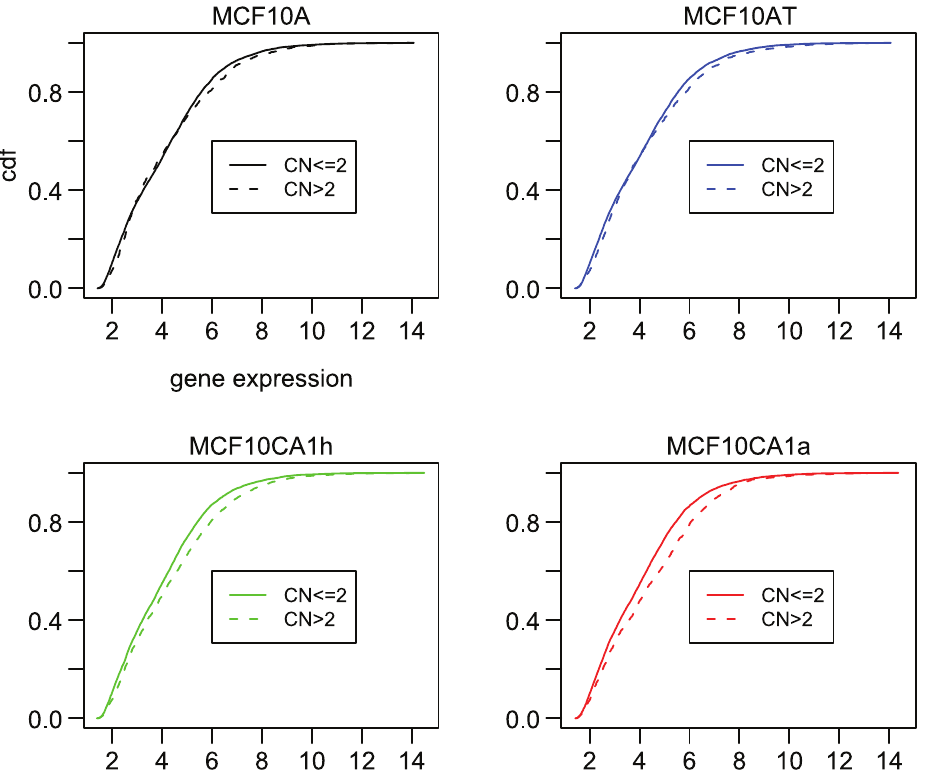
Figure 5. The effect of chromosome copy number gain on gene expression in the MCF10A series of cell lines. For each cell line, genes are grouped into those showing copy number (CN) greater than 2 (CN . 2, dashed lines) and those showing copy number equal to or less than 2 (CN # 2, solid lines). Expression levels of genes are indicated along the X-axis. The Y-axis represents the cumulative distribution function (cdf), which describes cumulative probability of gene expression less than or equal to the threshold level indicated by the value on X-axis.The data depicted in this figure indicate show largedifference between the expression levels for genes with copy number gain (CN . 2) versus those with no gain (CN # 2) only in the two malignant cell lines, MCF10CA1h and